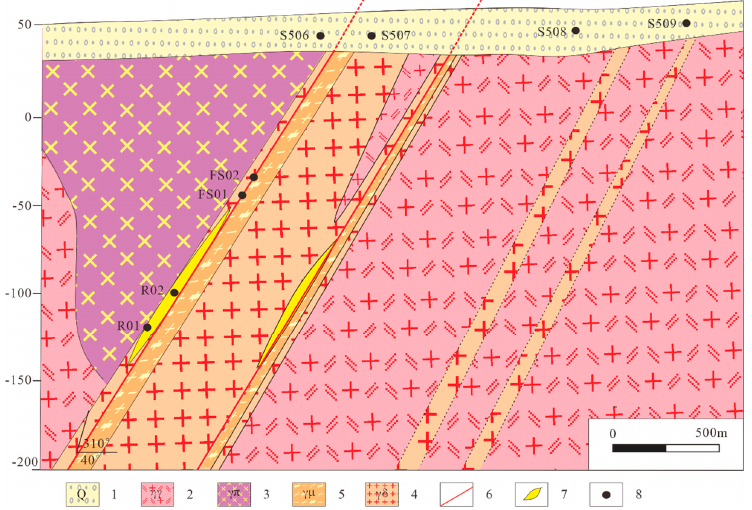
Figure 1. Sampling points profile of Jiaojia gold mine. 1-quaternary clayey coarse sand and fine sand; 2-biotite monzogranite; 3-medium-fine-grained gabbro; 4-pyrite sericite granite; 5-pyrite se-